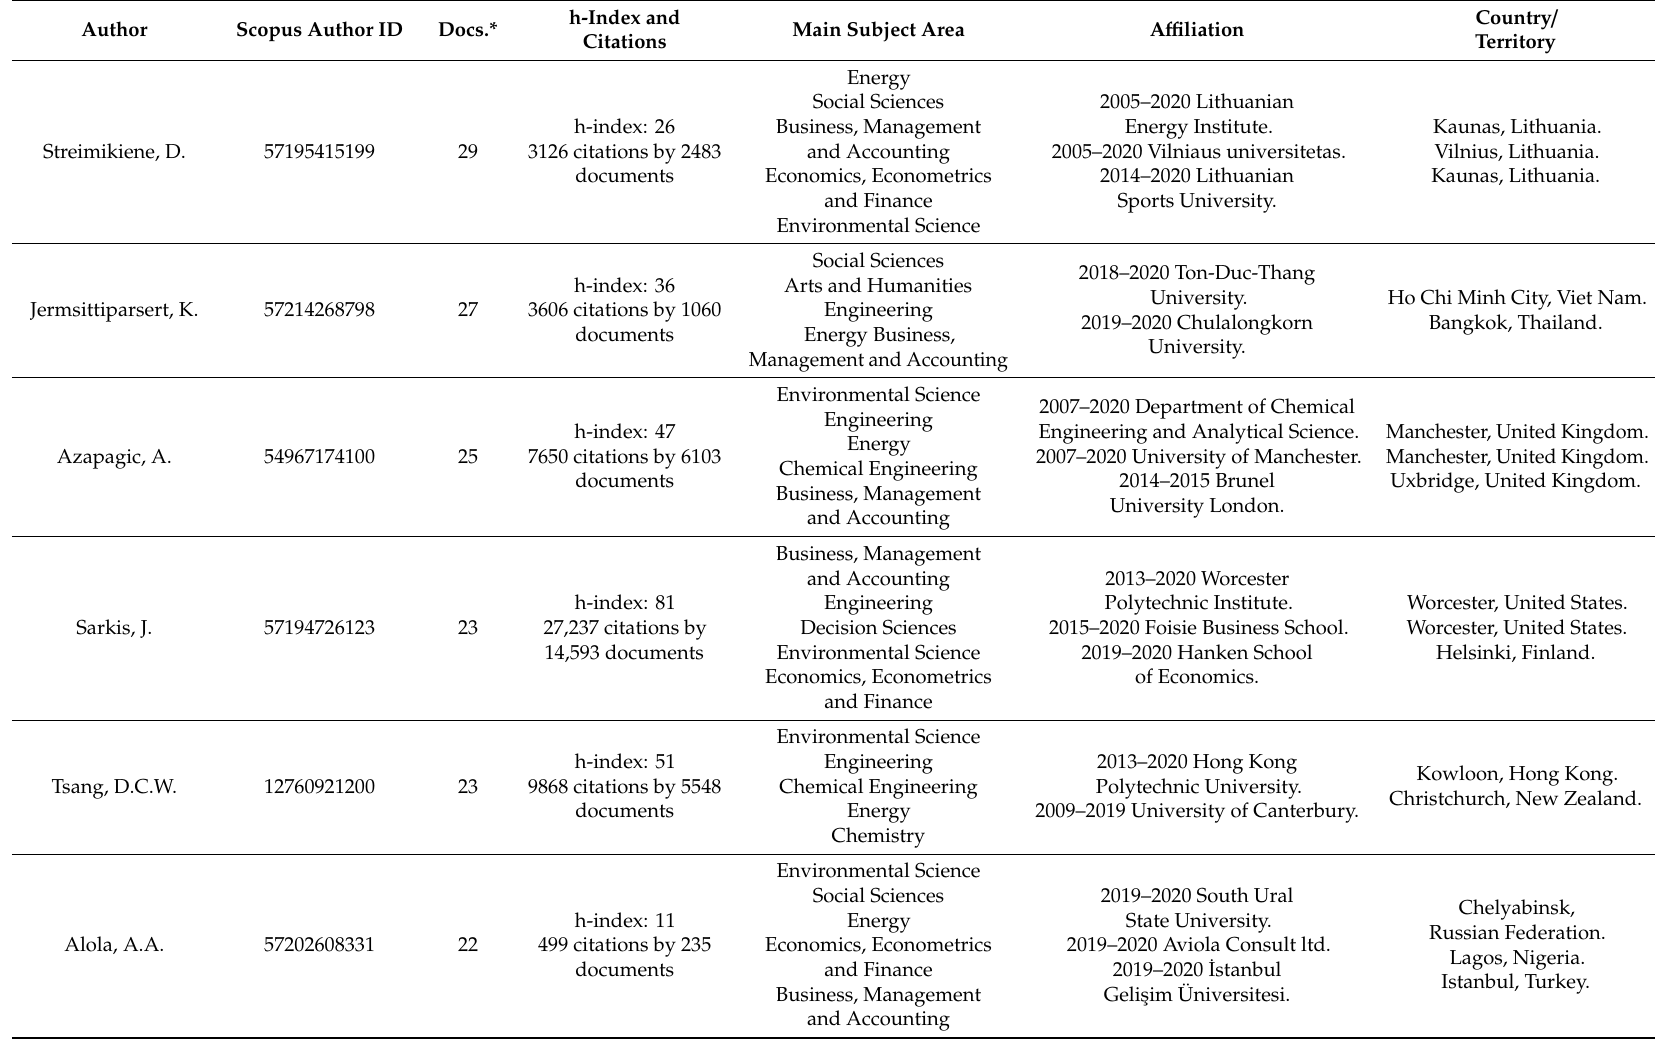
Table 9. Main authors in sustainability in the short